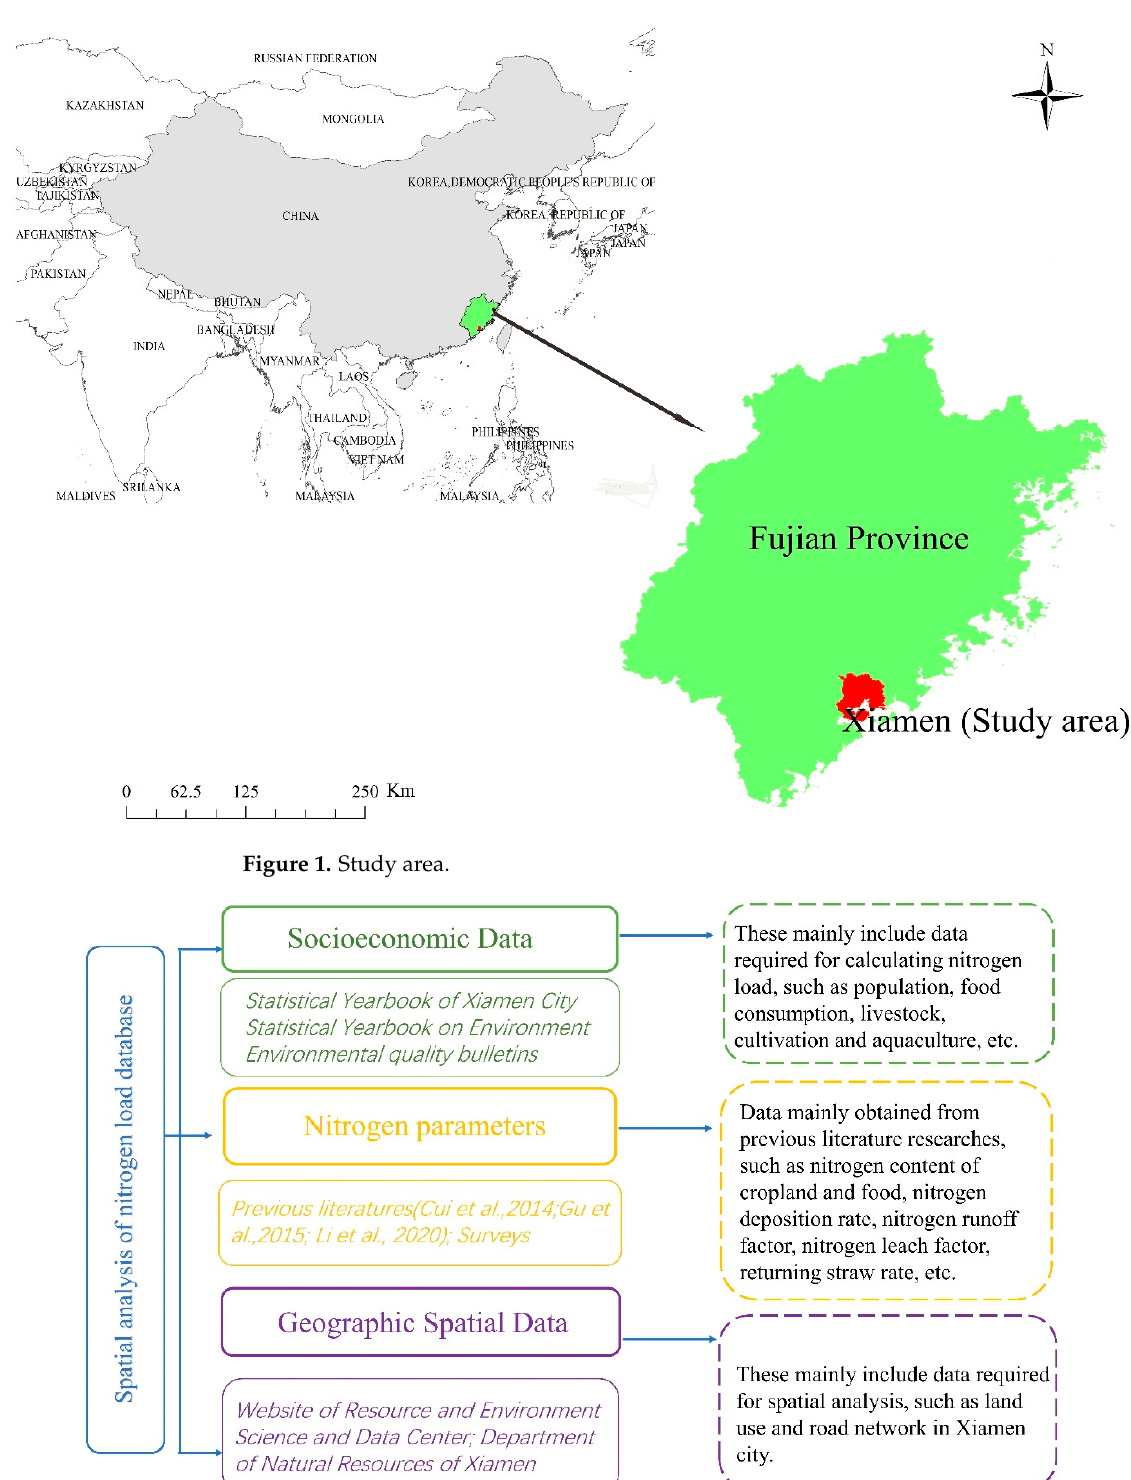
Figure 2. Construction of the spatial analysis of the nitrogen loads database .